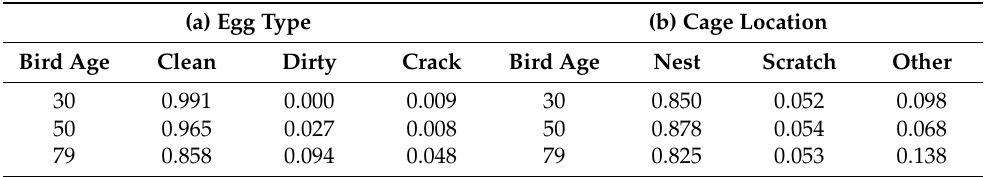
Table 4. Within Bird Ages (weeks), the Mean Proportion of Observed Eggs Laid by: ( a ) Egg Type (clean, dirty and crack); ( b ) Cage Location (opposite the nest box, scratch mat, all other areas).